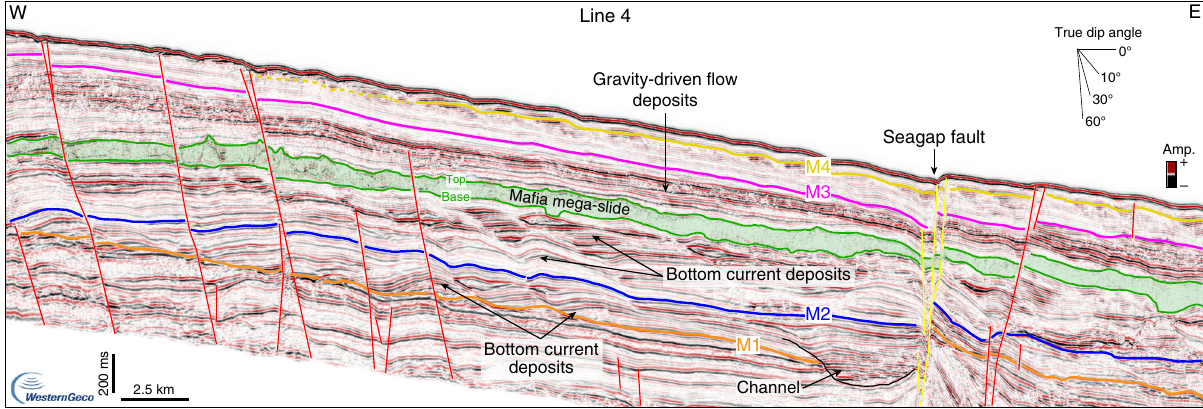
Fig. 6 Downslope-oriented seismic line across the Ma fi a mega-slide. Seismic Line 4, oriented W-E, shows: (1) high-amplitude and wavy re fl ections with an upslope direction of progradation (to the west) between horizon M1 and the base of the Ma fi a mega-slide, that are interpreted as bottom current deposits (i.e., sediment waves formed by ocean circulation); (2) continuous to discontinuous and high-amplitude re fl ections, mainly sub-parallel, between the top of the Ma fi a mega-slide and horizon M3, that are interpreted as coarse-grained gravity-driven fl ow deposits; (3) continuous and low-amplitude re fl ections between M3 and M4, that are interpreted as shaley deep-water pelagic deposits and that become more in fl uenced by ocean bottom currents above M4, where sediment waves are again visible. Noninterpreted version of Line 4 is available in the Supplementary Fig.